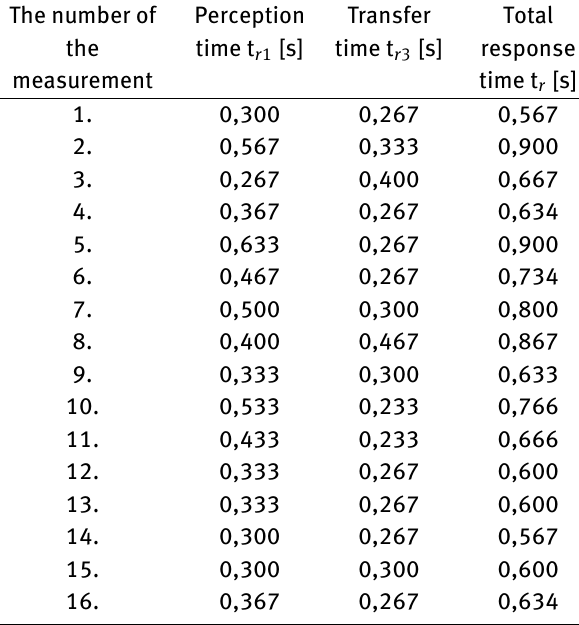
Table 16: Summary of the results of driver